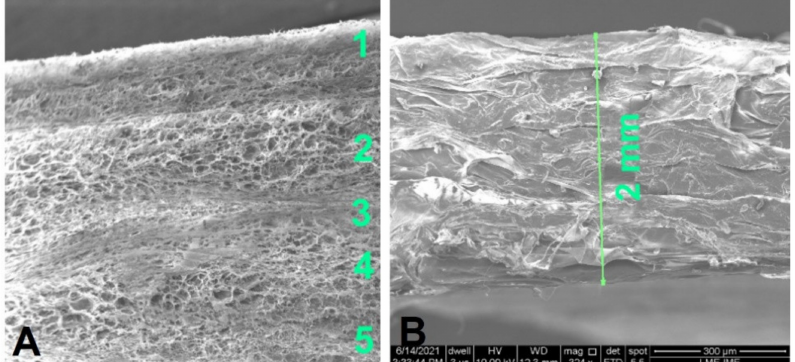
Figure 2. Type I collagen membrane morphology. One can see 5 layers of collagen fibers ( A ) and marginal sealing ( B ). The characteristics of the membrane ensure good elasticity, wettability, and permeability.